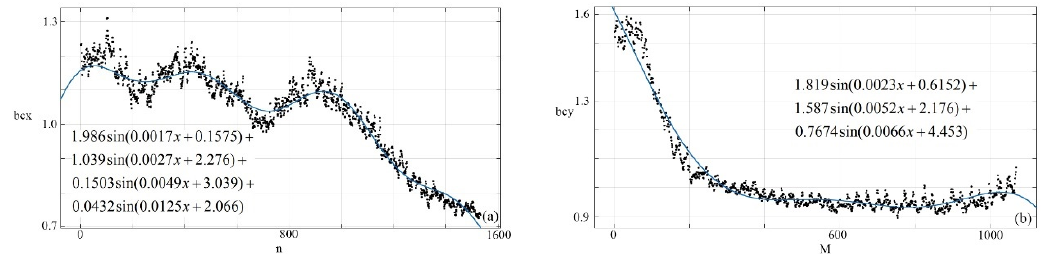
Figure 9. The model of brightness compensation. ( a ) The model of row direction. ( b ) The model of column direction.